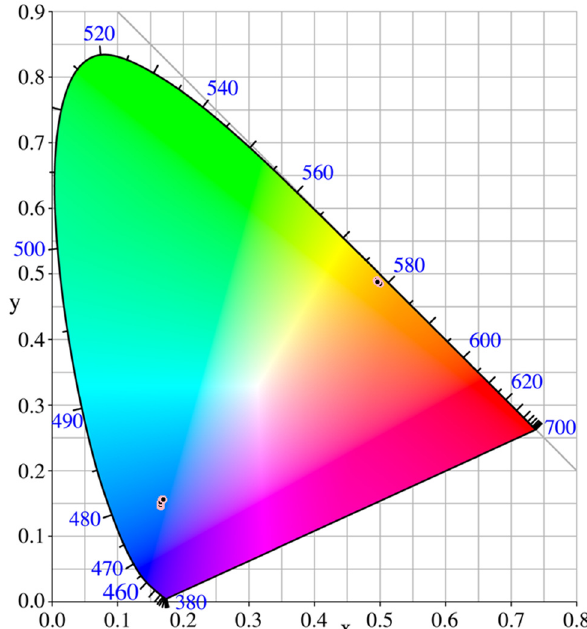
Figure 9: CIE chromaticity coordinates ( x , y ) positions of Ce 3 + - doped YVO 4 single crystals excited at 325 nm ( a ) and 460 nm ( b ) in the Commission Internationale de I ’ Eclairage ( CIE ) 1931 chromaticity